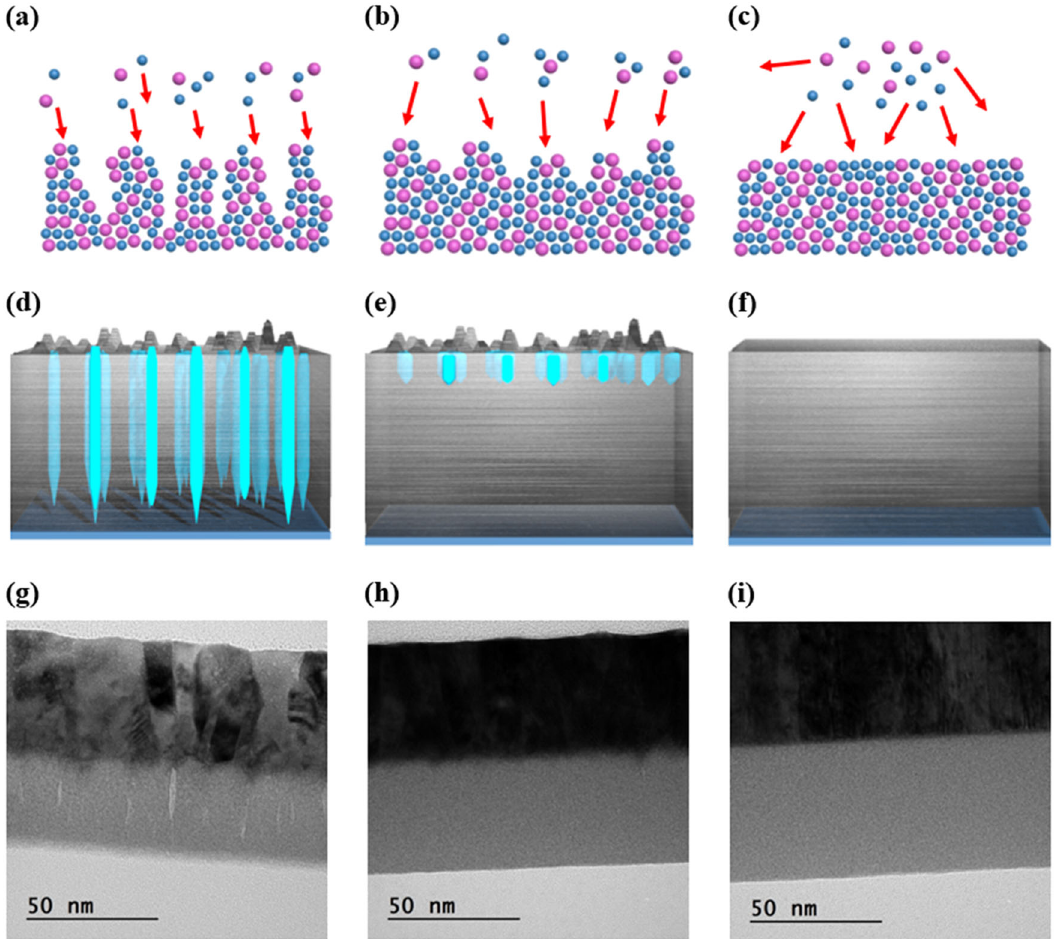
Fig. 2 Growth mode and analysis of amorphous metal thin fi lm. Schematic diagram of amorphous metal layer with different growth modes. a Volmer-Weber mode which has column structure, b Stranski-Krastanov mode with partial voids, and c Frank-van der Merwe mode with compact amorphous structure. Schematic of atomic growth with d low, e intermediate, and f high kinetic energy. TEM images of FeZr thin fi lm with different sputtering pressure w/ Pt capping layer. g 11mTorr, h 7mTorr, and i 3mTorr,